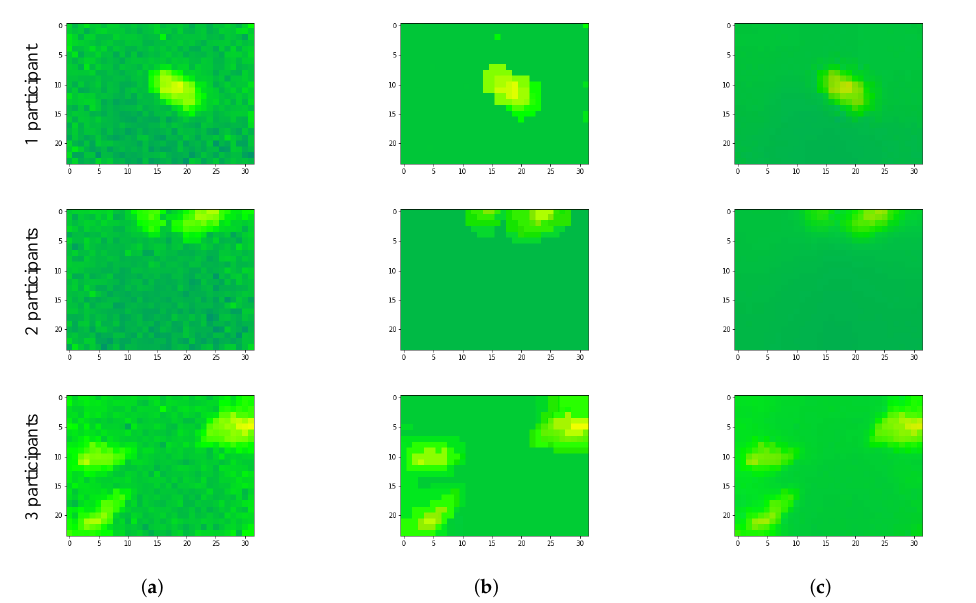
Figure 7. Examples of frames denoised using different techniques. ( a ) Original Frames, ( b ) Frames “aggressively” denoised, ( c ) Frames denoised using NLMD.